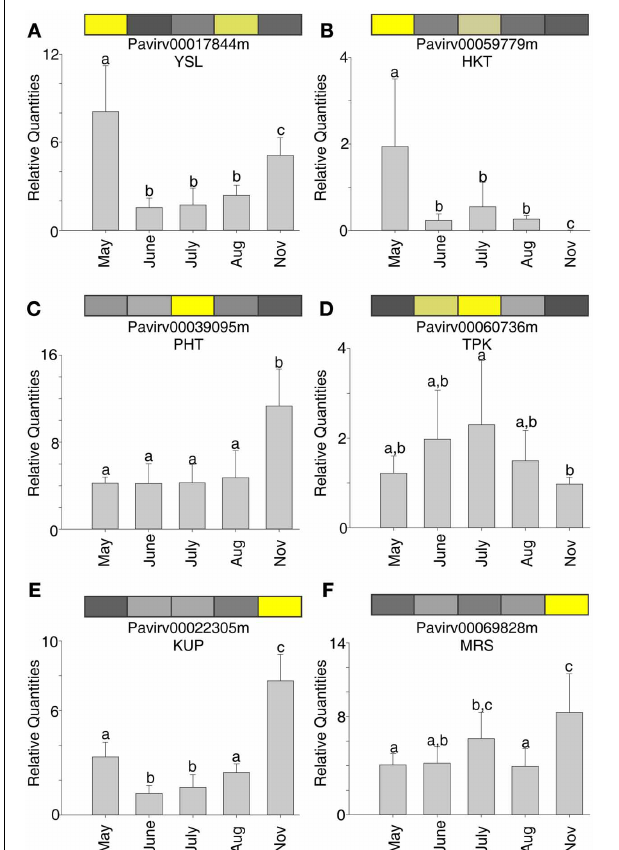
FIGURE 7 | Correspondence between expression profiles observed in NGS datasets to qRT-PCR data for six select switchgrass transporter genes. (A) YSL; (B) HKT; (C) PHT; (D) TPK; (E) KUP; (F) MRS. Colored bar at the top of each panel is the expression profile for each gene observed in the 454 NGS dataset (see Figure 2 ). Yellow is high expression and black is low or negligible expression. Gray bars in each panel show the relative expression ( ± SD ) for each individual gene as determined by qRT-PCR. Different letters above each bar was significantly different expression at P < 0 . 05. See text for more